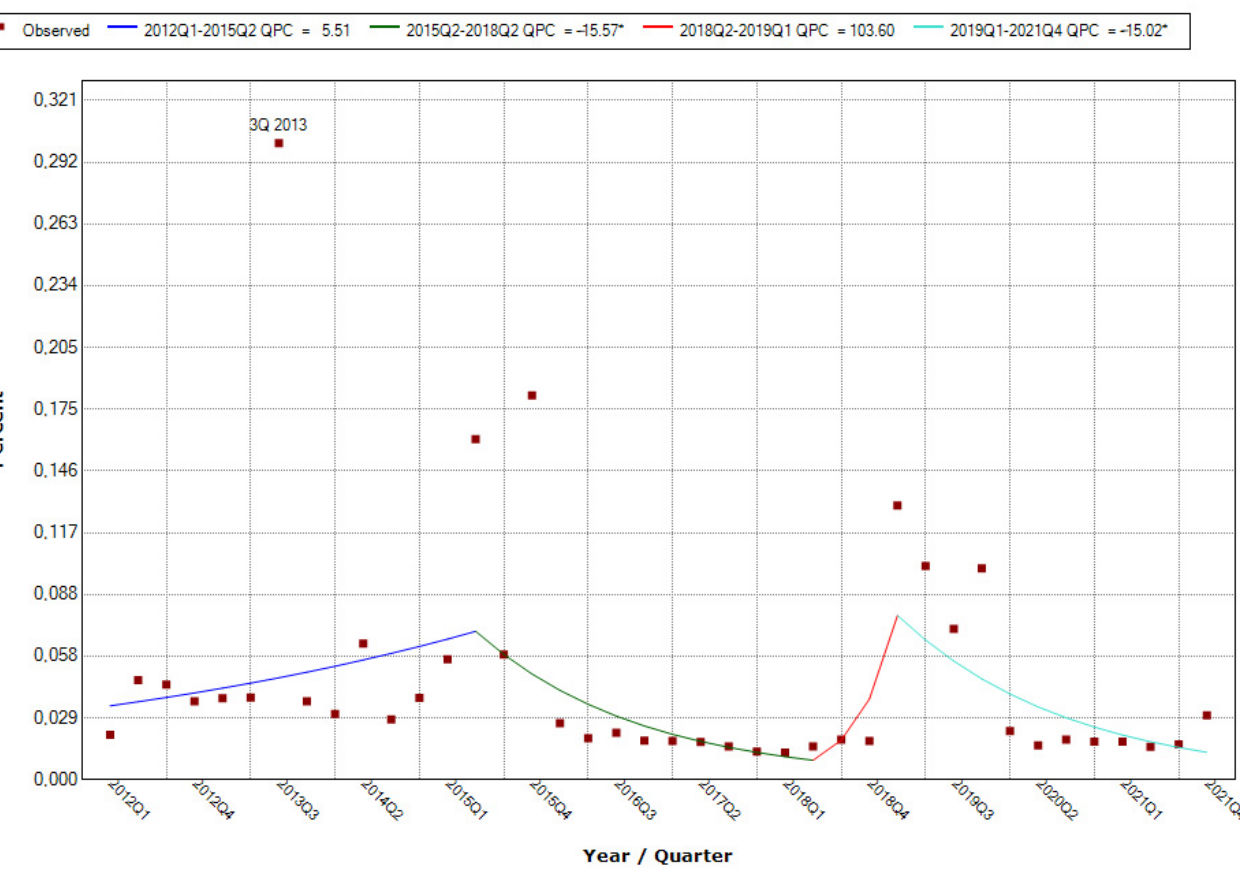
Figure A35. Percentage of products containing yohimbine in individual quarters in the period from 2012 to 28 November 2021. Joinpoints mark trend turning points. The date above the observation indicates the moment of publication of the scientific opinion/resolution.